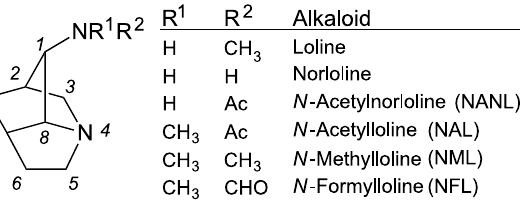
Fig. 1. Structures of common loline alkaloids. Substitutions on the nitrogen at C1 differentiate the lolines.